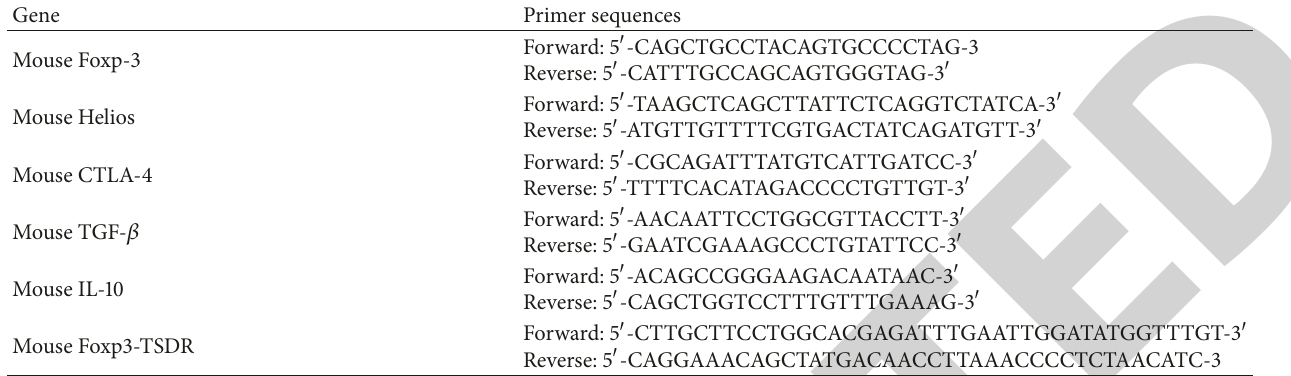
Table 1: Targeted genes and their primer sequences for SYBR Green and Methylation-Sensitive Real-Time Polymerase Chain Reaction. Gene Primer